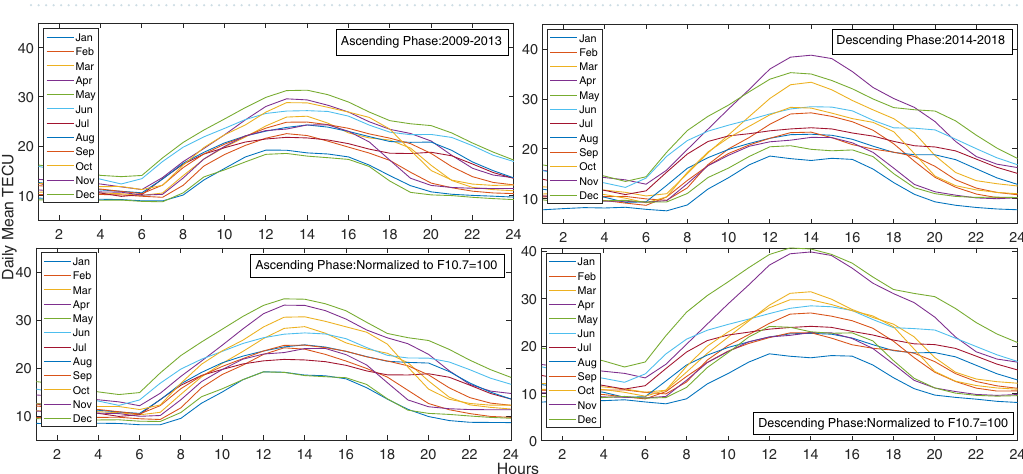
Figure 10. Diagrams of Monthly mean TECU in ascending and descending phases (top-left and right) and Monthly mean TECU normalized at F10.7 = 100 SFU during ascending and the descending phases (bottom-left and right).